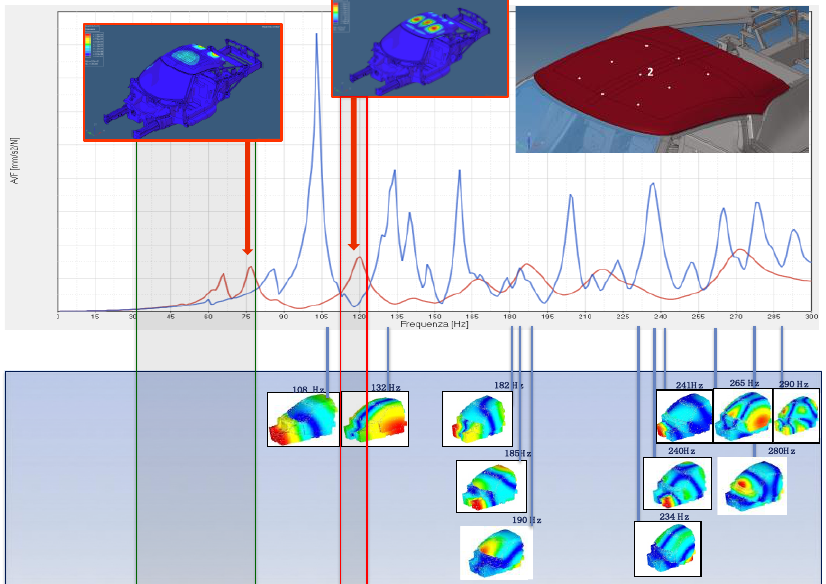
Figure 24. Analysis of potential coupling between the cavity and structure modes, considering the pavilion made of PP23FC OPTIMIZED (red line) and TCA (blue line).